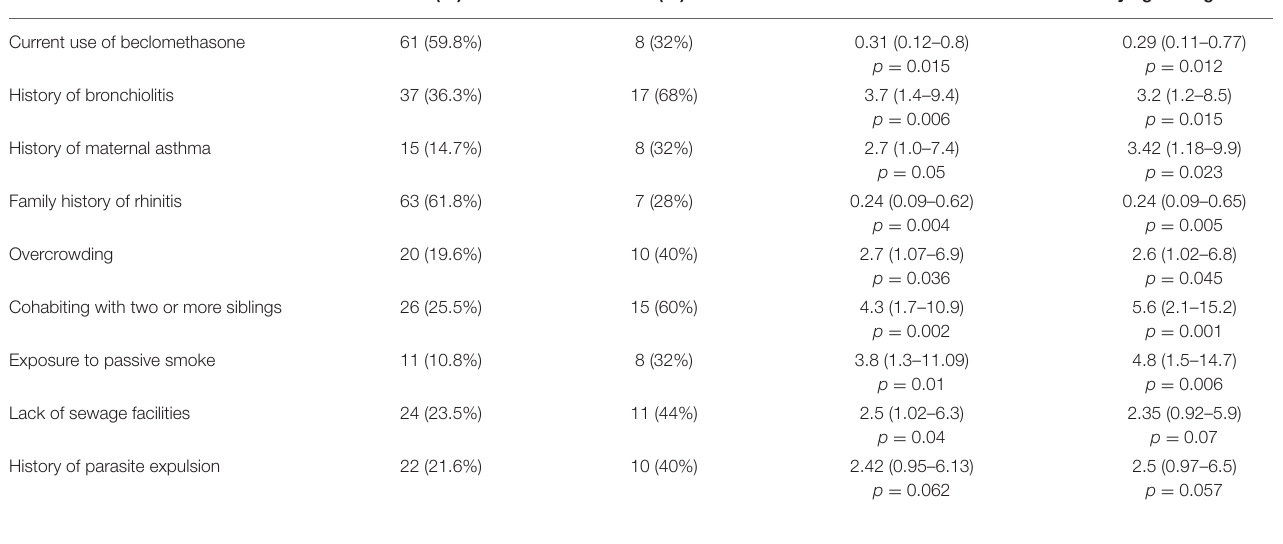
by age and gender